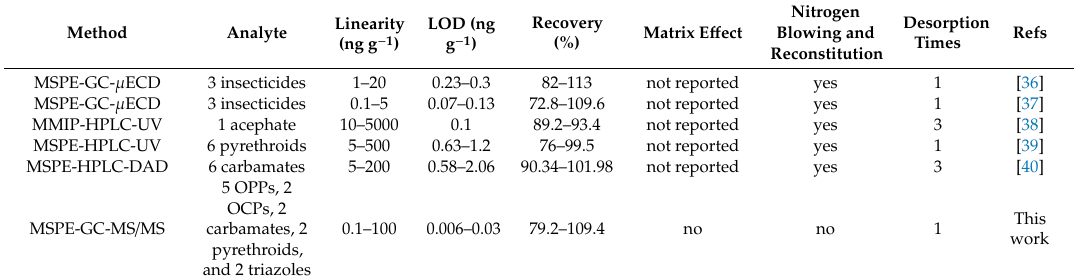
Table 3. Comparison of the current study with other MSPE techniques used for vegetable sample preparation.